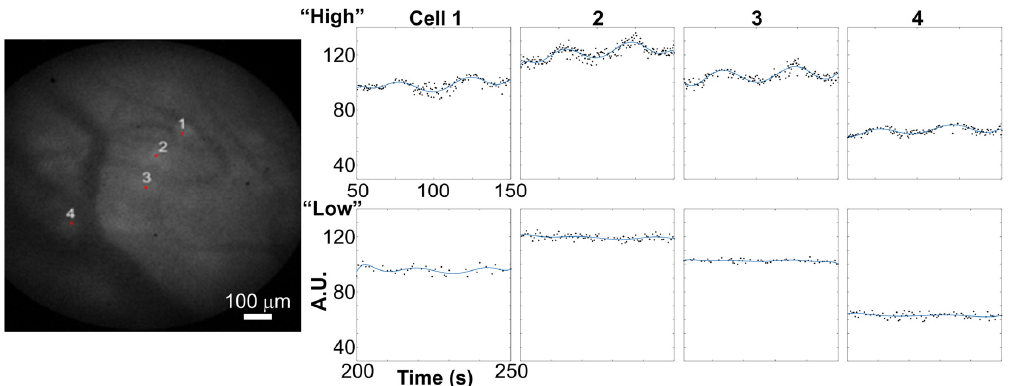
Figure 6. Heterogeneity in calcium fluctuations among astrocytes. Fluctuation of the intensity versus time in Set 2. The four active regions are marked in the brain image. The upper row shows the four active regions with “high” activity periods and the lower row plots the “low” activity periods. All plots have the same coordinate axes.